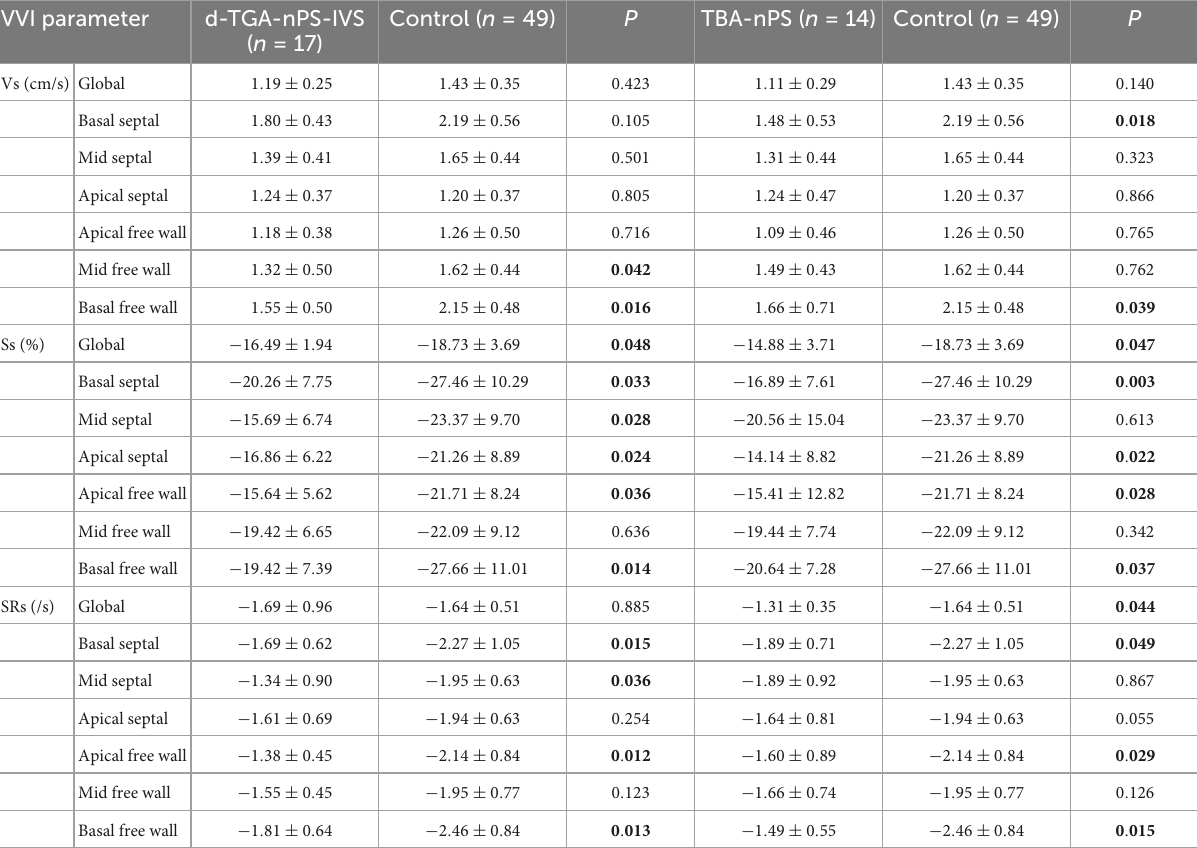
TABLE 4 Comparison of RV deformation parameters in d-TGA-nPS-IVS fetuses with control fetuses and TBA-nPS fetuses with control fetuses. VVI parameter d-TGA-nPS-IVS ( n =